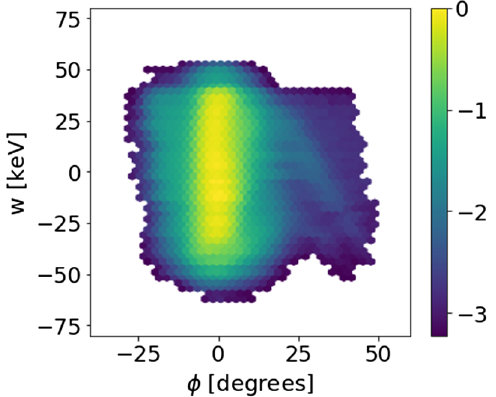
FIG. 8. Vertical phase space at the first slit with logarithmic intensity, showing the BSM wire bisecting the beam core. FIG. 7. Measured phase space partial projection near the beam ˆ f ð ϕ ; w Þj 6 × 10 − 4 of the At 1% threshold, the vetrical rms parameters are α ¼ − 0 . 07 , center, ˜ x; ˜ x 0 ; ˜ y 2 ∼ 0 . A threshold is applied at β ¼ 3 . 7 m = peak density.